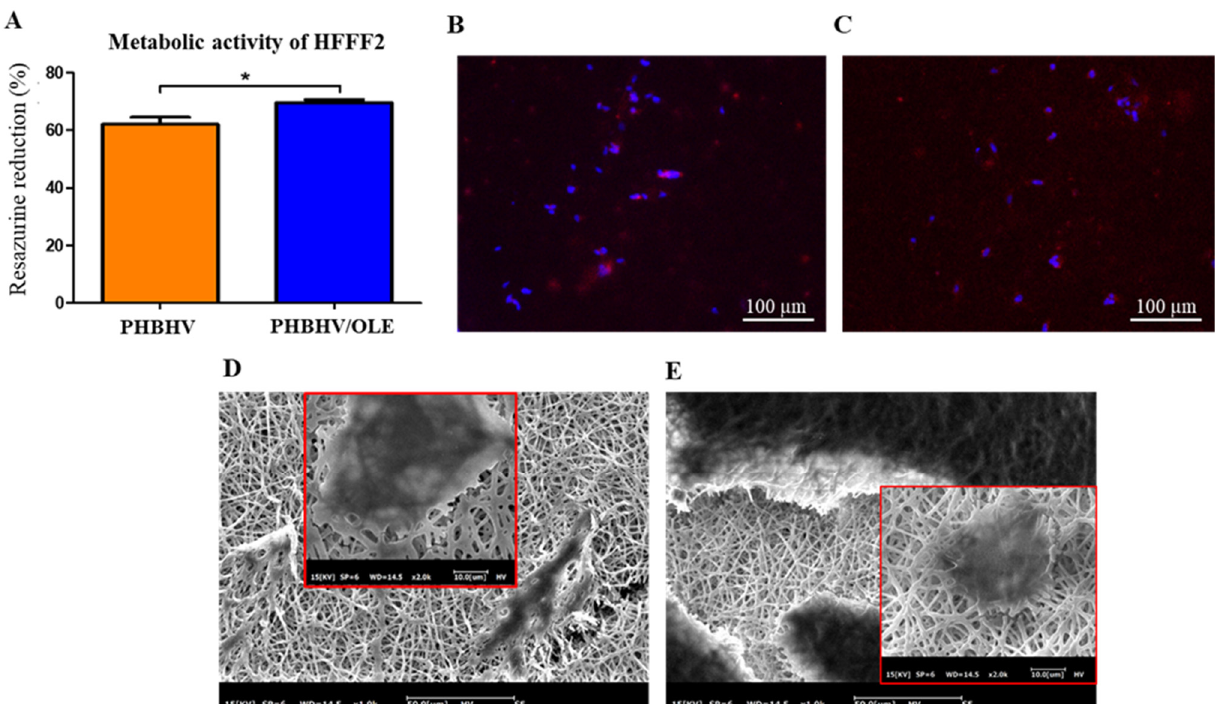
Figure 7. Cytocompatibility of PHBHV and PHBHV/OLE scaffolds. ( A – C ) The scaffolds were cultured with fibroblasts (HFFF2) for 3 days: ( A ) bar graph showing the metabolic activity of the cells after 72 h ( n = 3; t -test; one way, * p < 0.01); ( B , C ) florescence staining of f -actin in red and nuclei in blue for ( B ) PHBHV and ( C ) PHBHV/OLE. The scale bar in ( B , C ) is 100 µm. ( D , E ) SEM micrographs of the scaffolds cultured with keratinocytes (HaCaT) for 3 days: ( D ) PHBHV and ( E ) PHBHV/OLE; scale bar is 50 µm. Lens showing details of cell attachment to the fibers; scale bar is 10 µm.